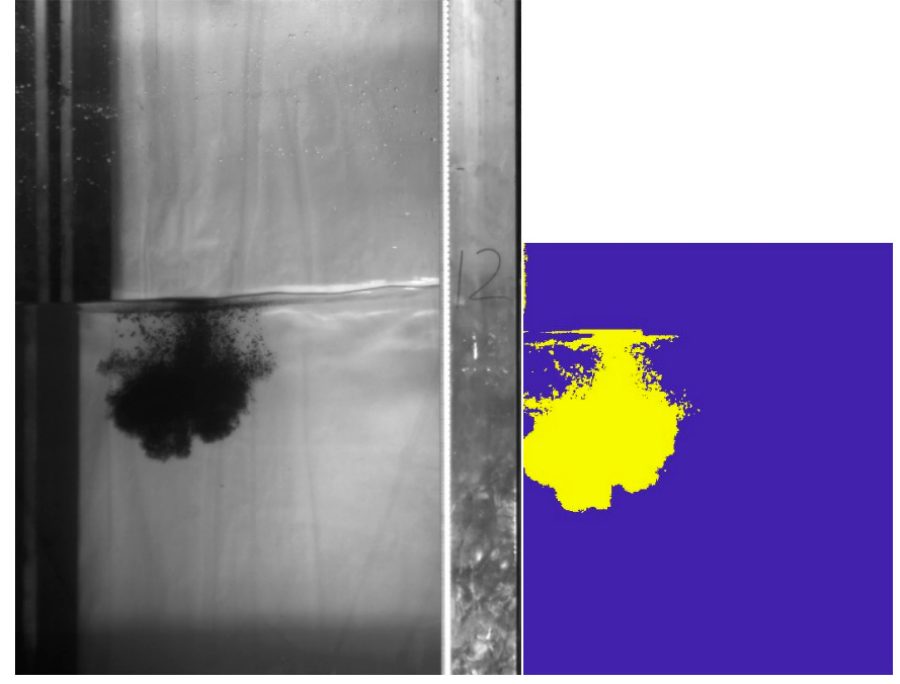
Figure 8. Spilled oil in the observation area without breaking wave.